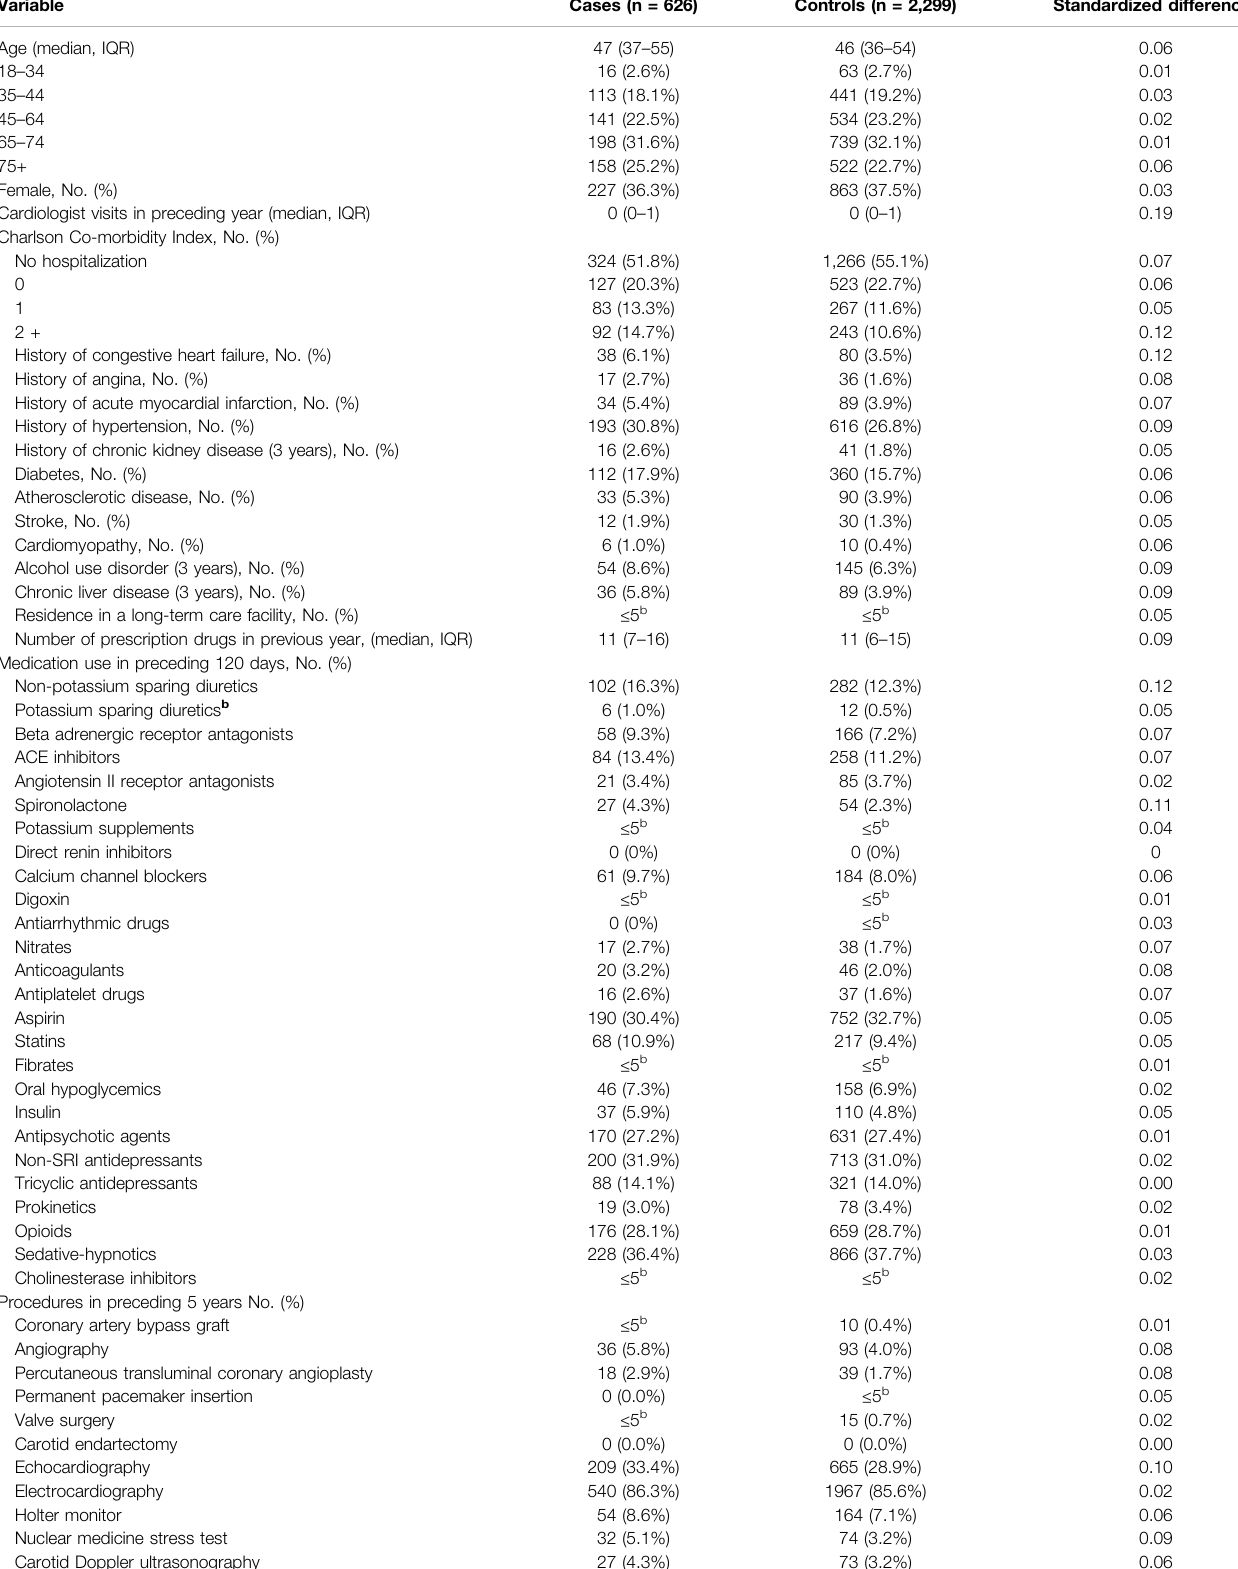
TABLE 1 | Characteristics of cases and